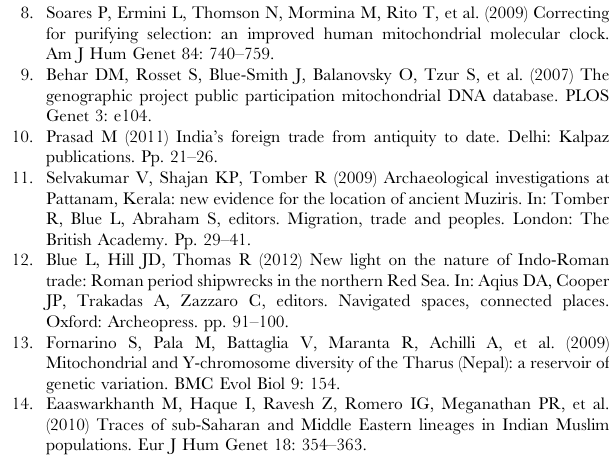
S1, Distribution of M49 and M65a haplotypes. Table S2, South Asian samples used in the present study.